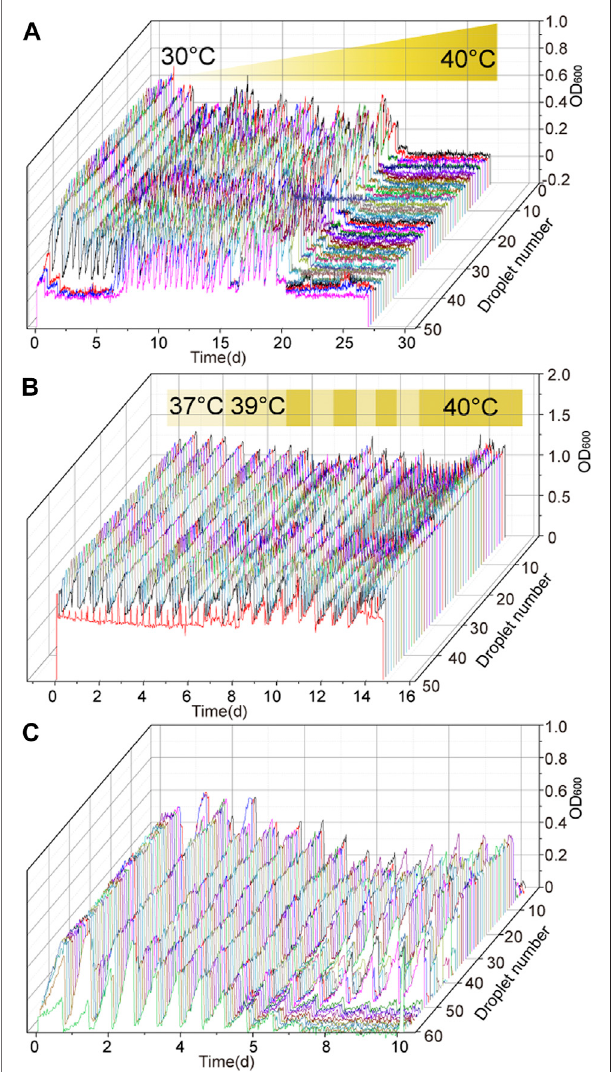
FIGURE4| Temperaturetoleranceadaptiveevolutionof G.oxydan s. (A) Adaptability evolution of G. oxydans to high temperature: the culture temperature and passage time were changed according to the growth of G. oxydans in MMC. (B) Adaptability evolution of G. oxydans to high temperature: the culture temperature was alternatively switched between 39 and 40 ° C. (C) Adaptability evolution of G. oxydans to high temperature: it was continuously cultured at 40 °